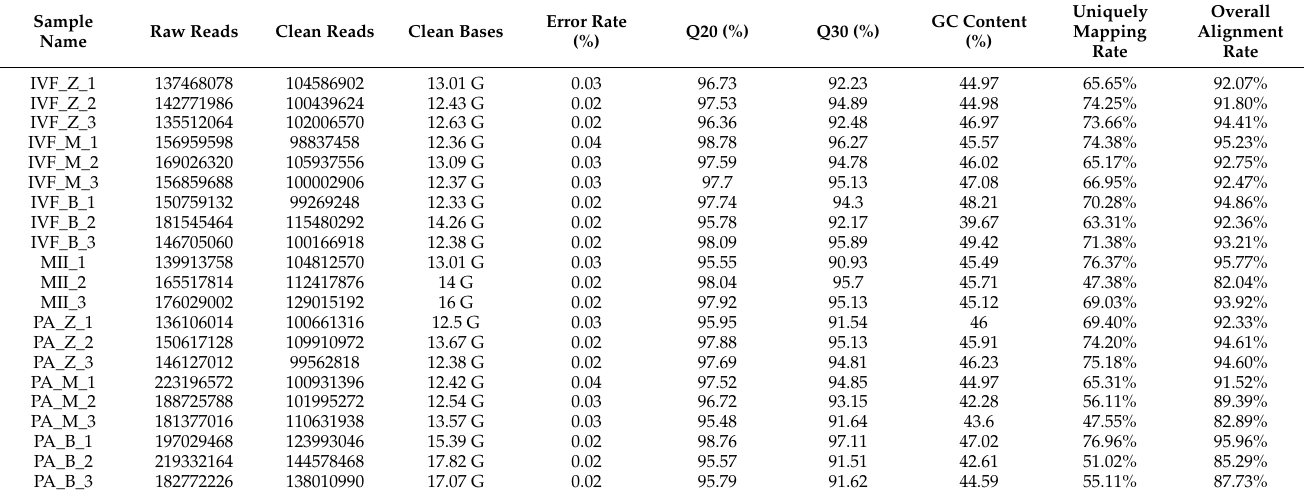
Table 2. In vitro embryo development of IVM oocytes after IVF or PA.